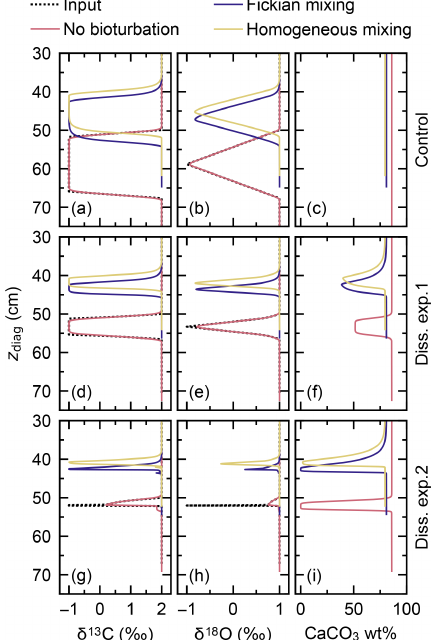
Figure 13. Proxy signals (a, b, d, e, g, h) and the weight fraction of bulk CaCO 3 in solid sediment (c, f, i) tracked by four classes of CaCO 3 particles plotted against diagnosed depth in simulations examining signal distortion by CaCO 3 dissolution. Two different water depth changes are considered, denoted as dissolution exper- iments 1 and 2, and compared to the case without water depth change, denoted as control. See Fig. 12c for the assumed water depth changes.